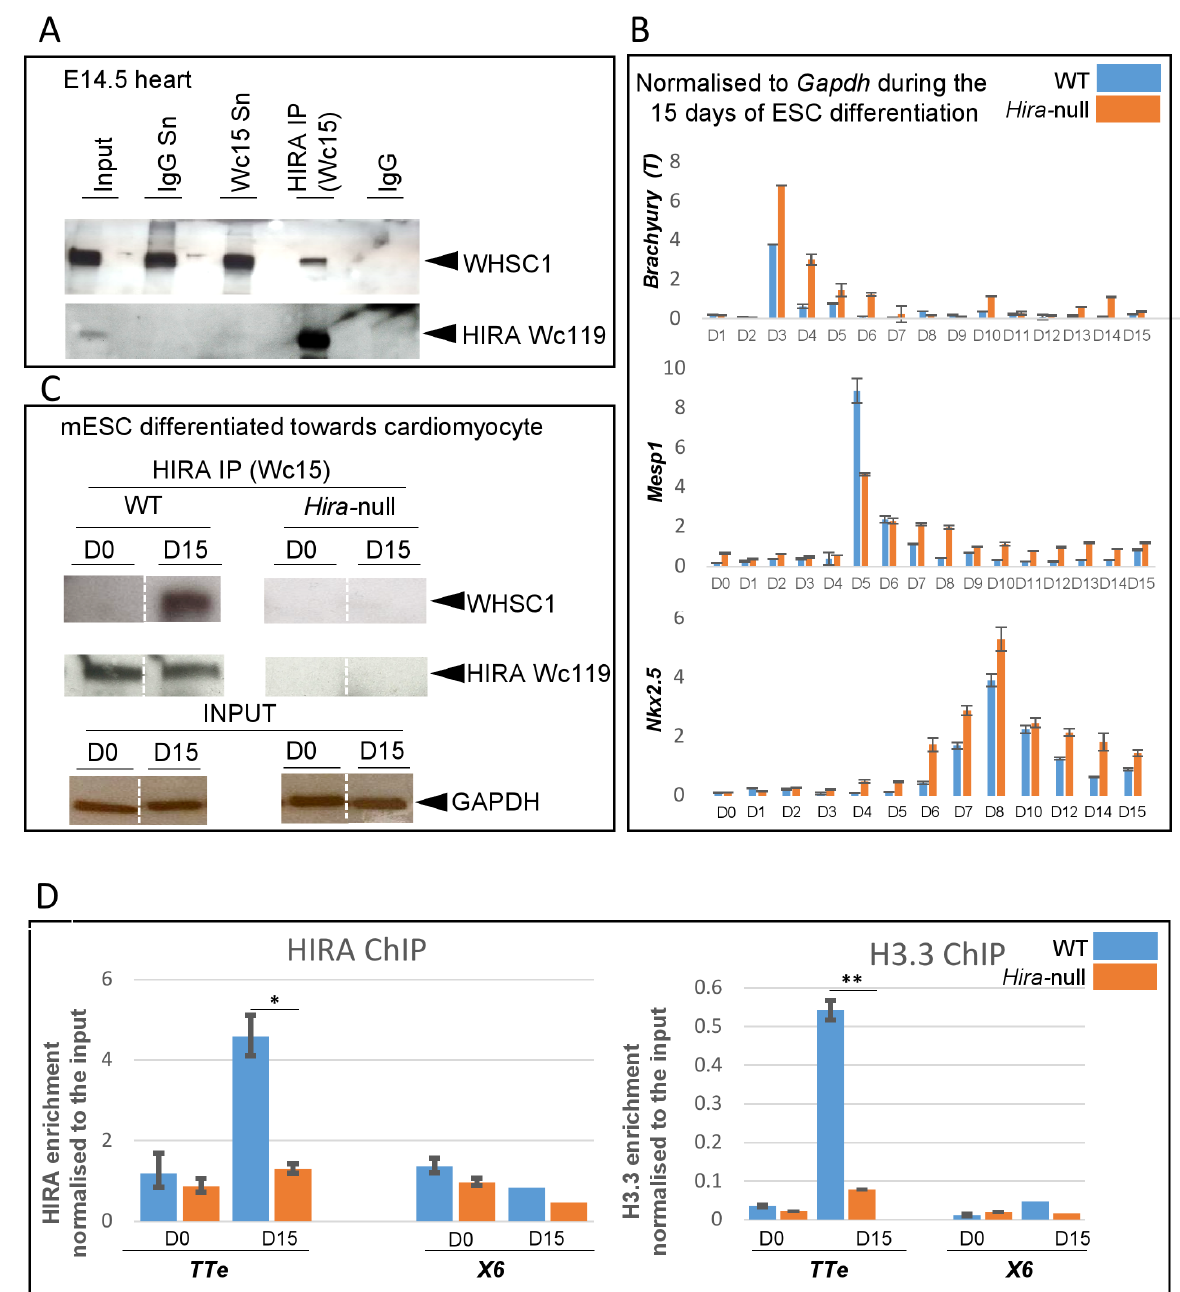
Fig 7. HIRA interacts with WHSC1 and binds to the TTe in the cardiac lineage and heart, and is required for differentiation- associated H3.3 enrichment at this locus. A. 20 E14.5 hearts from WT embryos were isolated, pooled and immunoprecipitated with HIRA Wc15 antibody and immunoblotted with WHSC1. Presence of HIRA in the IP was verified using Wc119 antibody. B. Mouse ESCs (control and Hira -/- ES cells) were differentiated towards cardiomyocytes over 15 days in LIF free medium following the hanging drop method, and were subjected to RNA and protein isolation. qRT-PCR of Brachyury (T) , Mesp1 and Nkx2 . 5 over the 15 days are presented and demonstrate sequential expression of the early mesoderm, cardiogenic mesoderm, and cardiac markers respectively. Data are shown as levels of mRNA normalized to Gapdh and are representative of five independent experiments. Errors bars represent the standard deviation of technical triplicates. C. Protein isolated from undifferentiated ESCs and 15 days differentiated control and Hira -/- ESCs were immunoprecipitated with anti-HIRA Wc15 antibody and immunoblotted with anti-WHSC1 antibody. The results shown are all from the same western membrane but separated lanes are brought into proximity and separated by dashed bars. GAPDH is used as a control for input. D. HIRA and H3.3 qChIP on differentiating ESCs shows an enrichment of HIRA at the TTe at day 15. H3.3 enrichment at the TTe increases significantly in WT but not in Hira null ESCs following this differentiation. X6 is an intergenic negative control region. Unpaired t-test was used: p < 0.05 * , p < 0.01 **